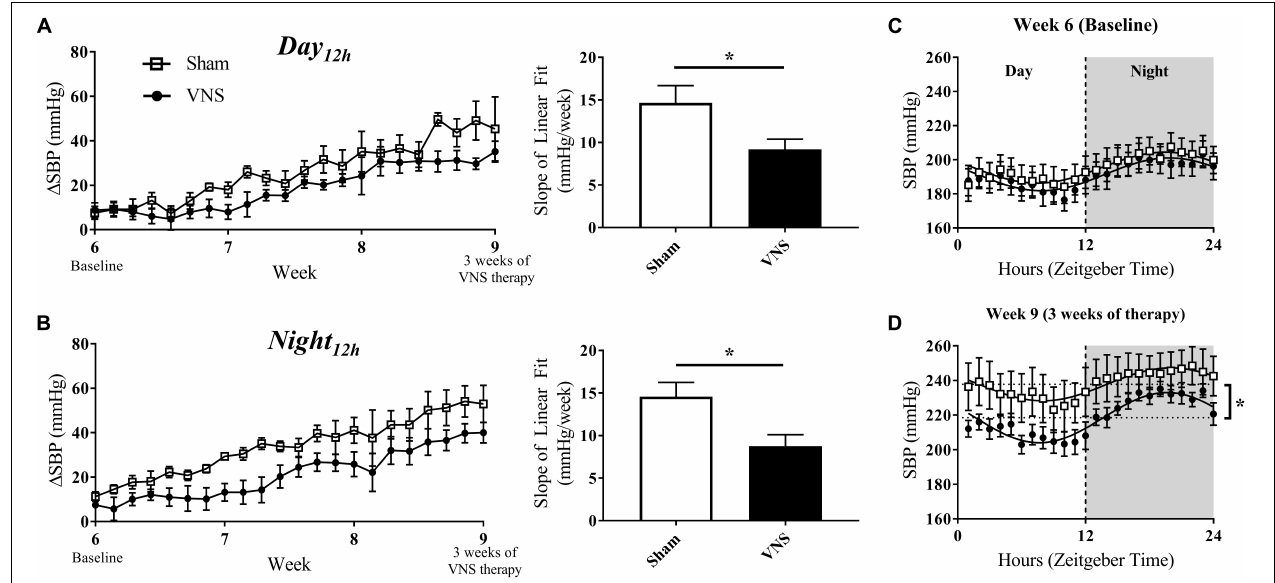
FIGURE 3 | Relative changes in SBP ( (cid:49) SBP) as HTN progresses. (cid:49) SBP as a function of time and slopes of the linear regressions are shown for Sham and VNS rats during the (A) Day 12h and (B) Night 12h intervals. Circadian rhythm of SBP for Sham and VNS rats are shown for Week 6 (C) and Week 9 (D) . ∗ Indicates statistical significance between Sham and VNS rats.